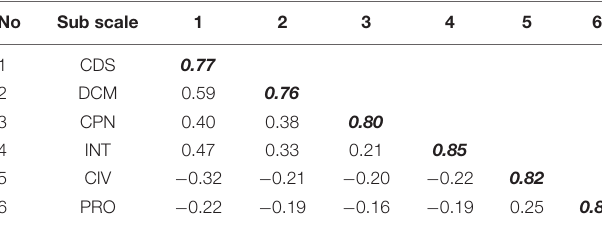
TABLE 4 | Fornell–Larcker